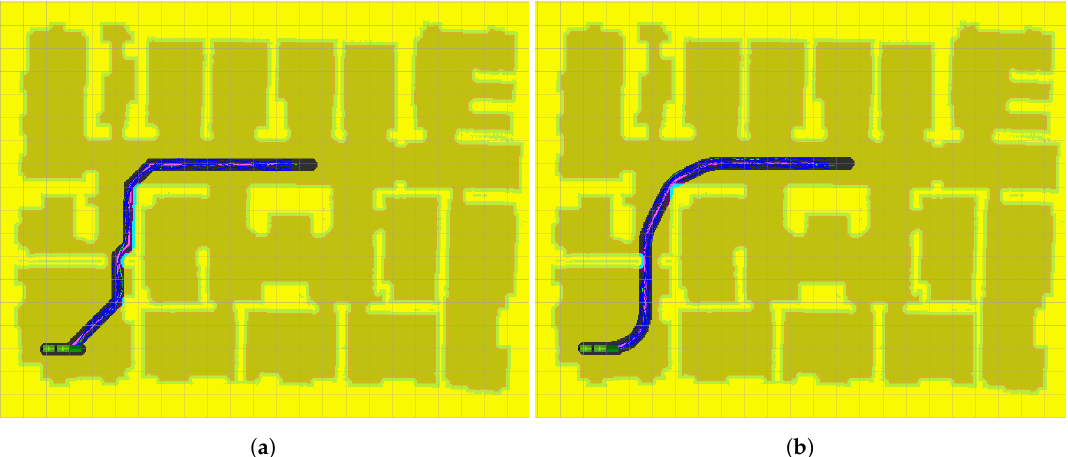
Figure 15. Goal 2 results: ( a ) Path planning with ARA*-RRT*; ( b ) Path planning with